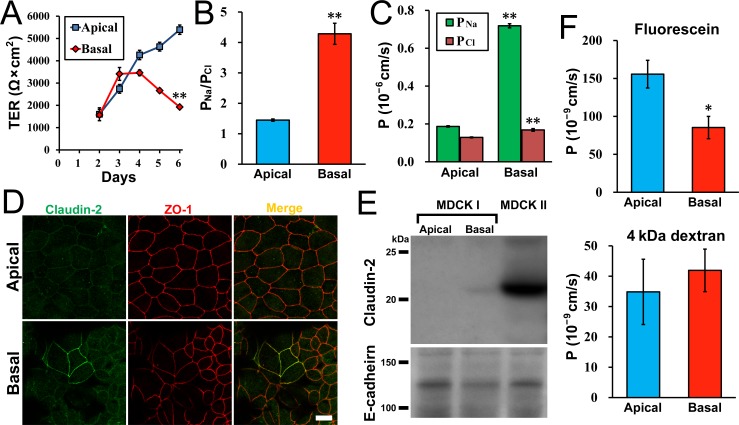
Effects of hydrostatic pressure on transepithelial transport.(A) Effects of hydrostatic pressure on transepithelial electrical resistance (TER) in MDCK I cells. The TER was changed to decrease at two days after application of the hydrostatic pressure under the ‘Basal’ condition. (B) The ratio of P
Na to P
Cl (P
Na/P
Cl) under the ‘Apical’ and ‘Basal’ conditions in MDCK I cells. The P
Na/P
Cl was measured at four days after the culture under the ‘Apical’ and ‘Basal’ conditions. The value of P
Na/P
Cl under the ‘Basal’ condition was significantly higher than that under the ‘Apical’ condition. (C) P
Na and P
Cl under the ‘Apical’ and ‘Basal’ conditions in MDCK I cells. The value of P
Na under the ‘Basal’ condition was approximately four-fold higher than that under the ‘Apical’ condition. (D) Immunofluorescence microscopy for claudin-2 and ZO-1 in MDCK I cells at four days after the culture under the ‘Apical’ and ‘Basal’ conditions. Claudin-2 staining was clearly detected at cell-cell contacts in a limited region under the ‘Basal’ condition. Scale bar = 10 μm. (E) Immunoblots for claudin-2 and E-cadherin in MDCK I cells at four days after the culture under the ‘Apical’ and ‘Basal’ conditions. MDCK II cells cultured on filters for six days were used as a positive control. A faint band of claudin-2 was detected under the ‘Basal’ condition in MDCK I cells. (F) Flux of fluorescein and 4 kDa FITC-dextran under the ‘Apical’ and ‘Basal’ conditions in MDCK I cells. The flux was measured at four days after the culture under the ‘Apical’ and ‘Basal’ conditions. The flux of fluorescein under the ‘Basal’ condition was significantly lower than that under the ‘Apical’ condition. * p < 0.05, ** p < 0.01 compared with the ‘Apical’ condition.